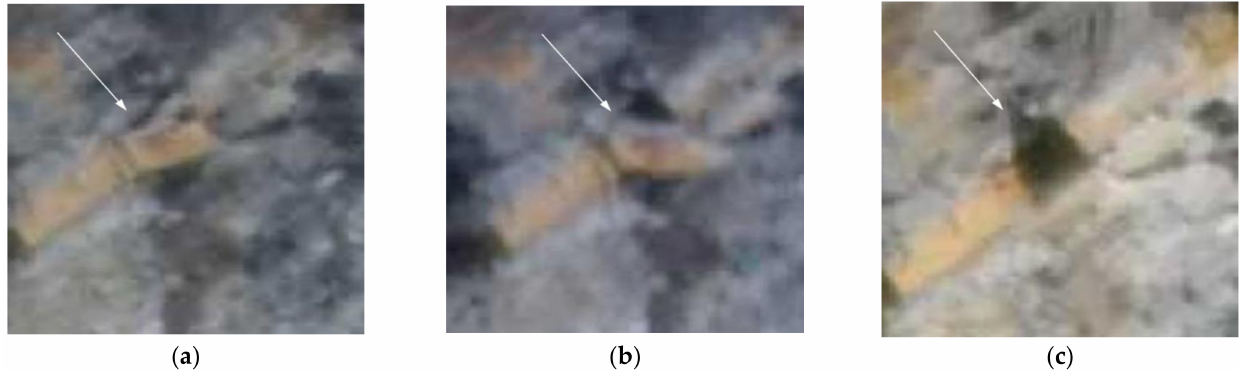
Figure 9. Evidence of precursory movements before the rockfall event as indicated by the withe arrow: ( a ) Zoomed Gigapixel image of 14 May 2019; ( b ) Zoomed Gigapixel image of 15 May 2019 with the tilted rock block; ( c ) Zoomed Gigapixel image of 17 May 2019 after the